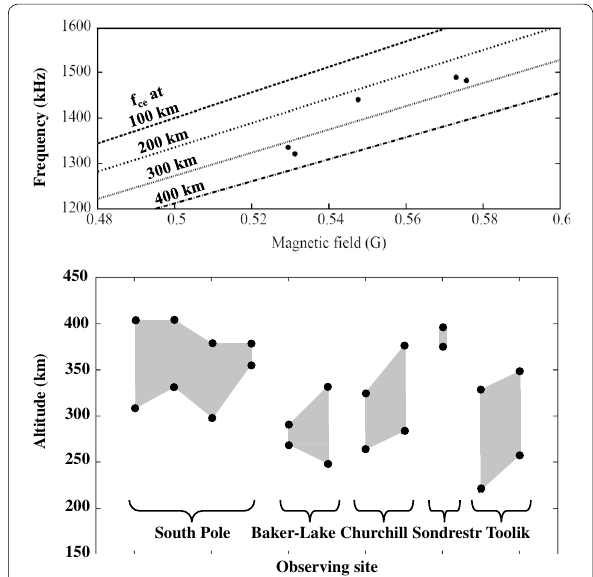
Fig. 5 a The average value of frequency of the lower cutoff of MFB emission, as a function of the magnetic field strength 100 km above the observing station. The frequency increases with magnetic field strength. Values of the electron gyrofrequency at altitudes of 100– 400 km are indicated for reference. b Altitudes where the electron gyrofrequency matches the top and bottom frequency of the gap in MFB emissions, for selected spectra at each observing